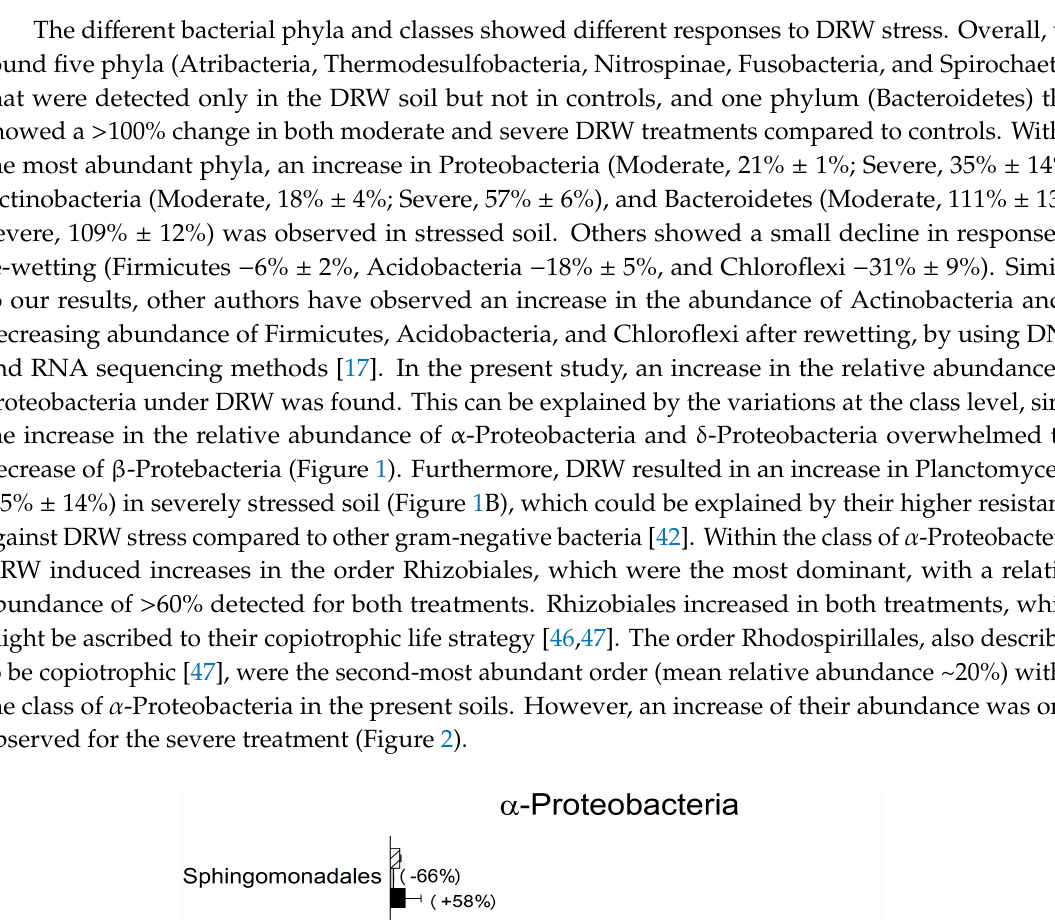
Figure 2. Changes in α -Proteobacteria abundance on the order level based on normalized spectral abundance factors (NSAFs). Moderate ― two cycles of four weeks of drought, then 75 mm irrigation (1 mm of precipitation refers to 1 mm of water depth per unit area); Severe ― one cycle of eight weeks of drought, then 150 mm irrigation. The percentage in brackets shows the change in unique proteins in total for each treatment. ‘Heterogeneous’ means di ff erent microbial taxa that belong to more than one phylum / class / order. Values are means ± standard deviation (n = 2 analytical